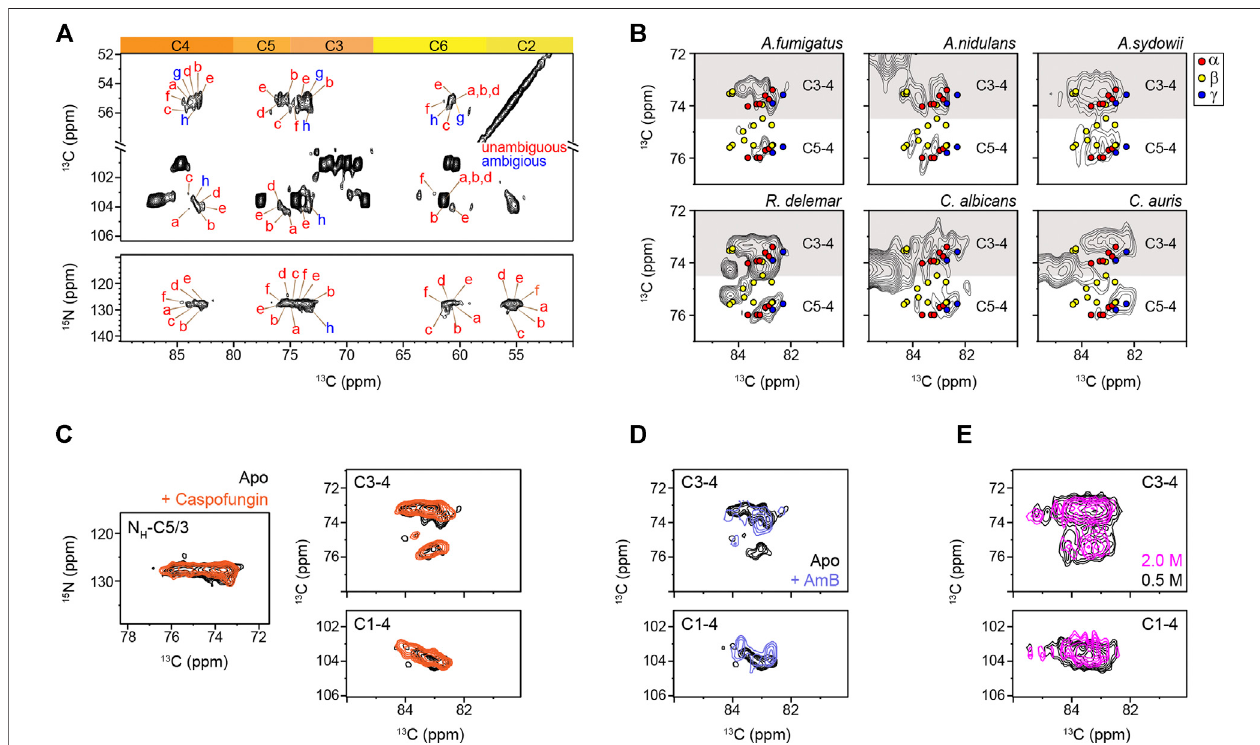
FIGURE 2 | Peak multiplicity of chitin in different fungi. (A) Representative signals of different chitin types in A. fumigatus . 13 C- 13 C (top) and 15 N- 13 C (bottom) correlation spectra resolved different forms of chitin molecules. Chitin forms with all carbon sites unambiguously resolved are labeled in red (types a – f), while the ambiguousformsareinblue(typesgandh),withtheambiguous(partiallyresolved)carbonsitesunderlined. (B) Comparisonofchitinsignalsindifferentfungi.TheC5-C4 andC3-C4regionsareshown.Coloreddotsdenotethedatafromthreecrystallineformsofchitin: α -chitin(red), β -chitin(yellow), and γ -chitin(blue). (C) 2D 15 N- 13 C and 13 C- 13 Ccorrelationspectraof A.fumigatus withoutdrug(apo;black) and withcaspofungin treatment(orange). (D) 2D 13 C- 13 Cspectraof A.fumigatus withoutdrug (apo;black)andwithamphotericinB(AmB;blue).( E )Overlayof2D 13 C- 13 Ccorrelationspectracollectedontwo A.sydowii samplesculturedwith0.5 MNaCl(black)and 2 M NaCl